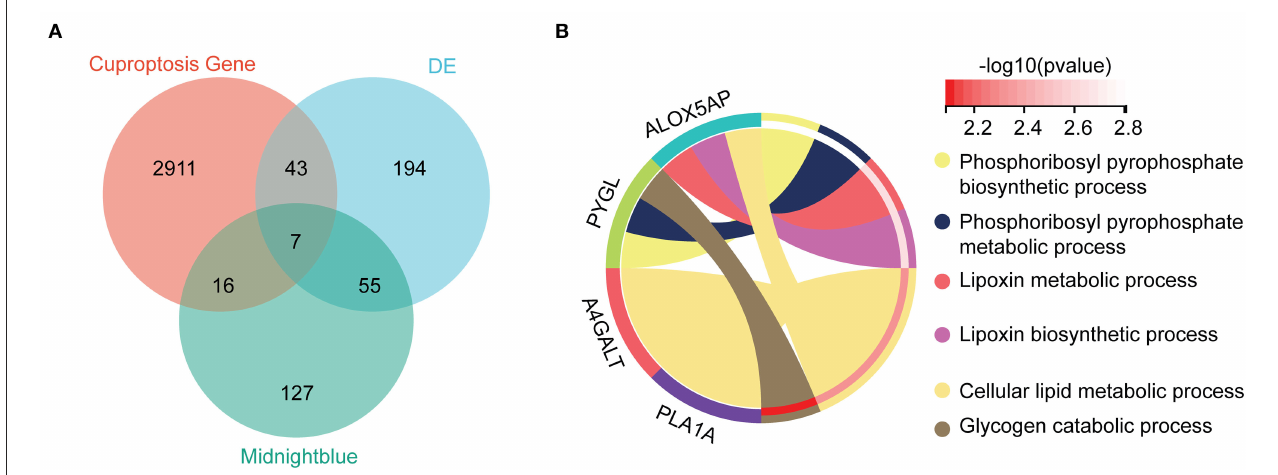
FIGURE4 Hub genes and GO analysis. (A) The intersections of the DE, cuproptosis genes, and midnight blue genes. (B) Biological processes in which the seven hub genes were involved.